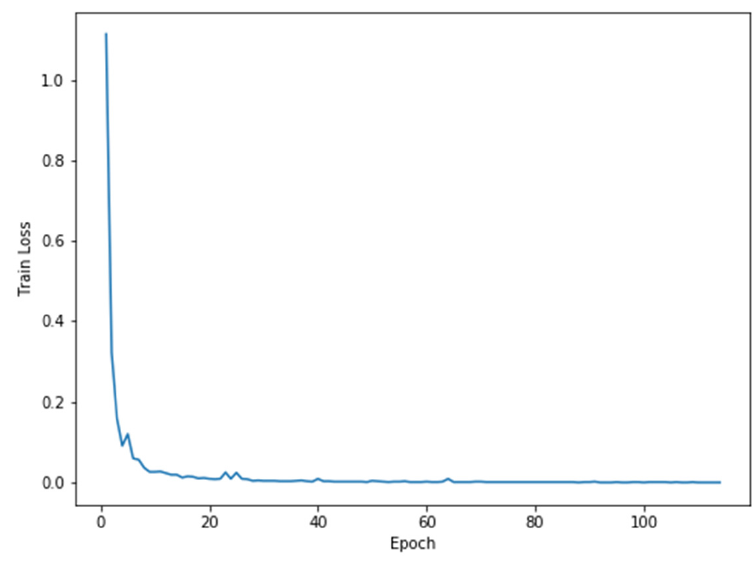
Figure 5. Training process of MSFLD on the HNUFDD dataset.